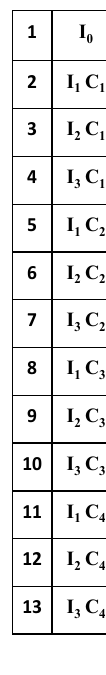
Water 2021 , 13 , x FOR PEER REVIEW